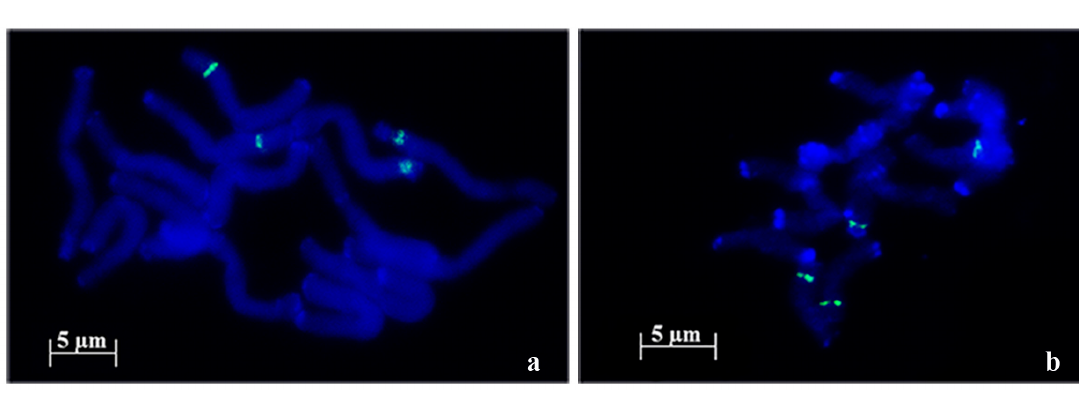
Figure 1. 45S rDNA fluorescent in situ hybridization (green signals) in metaphase cells of diploid A. strigosa . In the landrace from Madeira Island ( a ) two pairs of nucleolar organizing regions (NORs) with distinct sizes are observed and in the landrace from Elvas; ( b ) two pairs of NORs with similar sizes are detected.